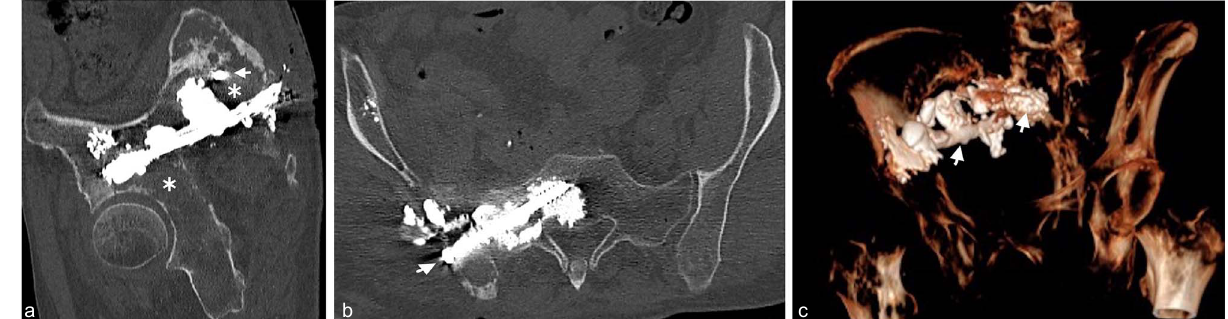
Figure 4. (a) Oblique sagittal reformatted view of post-procedure CT (bone window, slice thickness 1 mm) of the pelvic bones after inserting screws and fi rst step of cementoplasty. The cross section of the proximal part of the sacral screw is visible (small arrow). After this procedure, two large osteolytic areas compromising the whole stability of the osteosynthesis remained, one in the right acetabulum and the other in the right posterior iliac wing with no cement continuity between the two screws at that step (asterisk). (b) Oblique coronal reformatted view of post-procedure CT (bone window, slice thickness 1 mm) of the pelvic bones after inserting screws and fi rst step of cementoplasty shows the sacral screw (small arrow) anchored into the bone with cementoplasty and a slight extravasation of bone cement in soft-tissue. (c) 3D oblique anterior reformatted view of post-procedure CT shows the whole osteosynthesis with the two screws (small arrows) surrounded by cement.